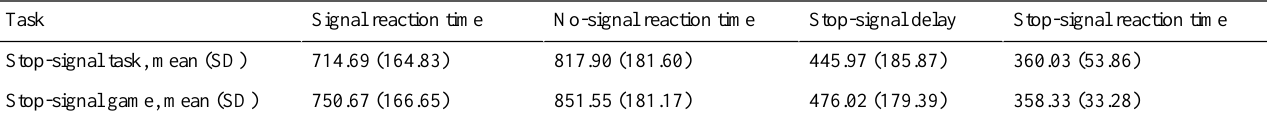
Table 1. Mean reaction time in milliseconds dependent on task type for study 1. The measurements are collapsed across the order of task performance.